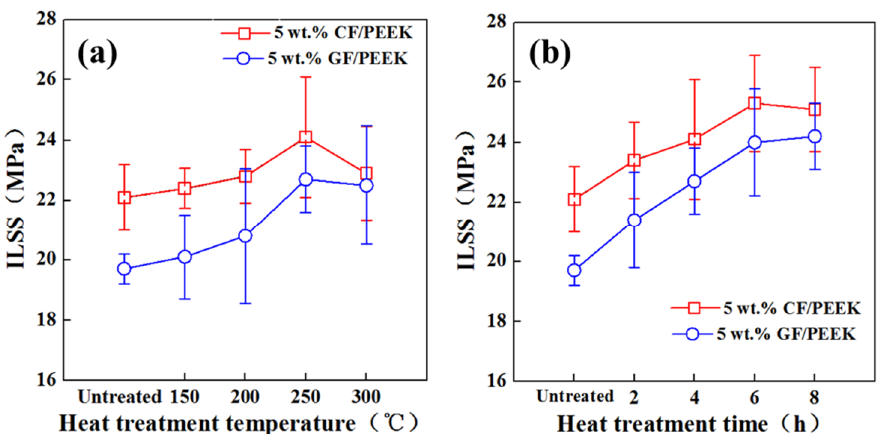
Figure 4. Effect of heat treatment process on ILSS of short-fiber-reinforced PEEK composites: ( a ) heat treatment temperature; ( b ) heat treatment time.